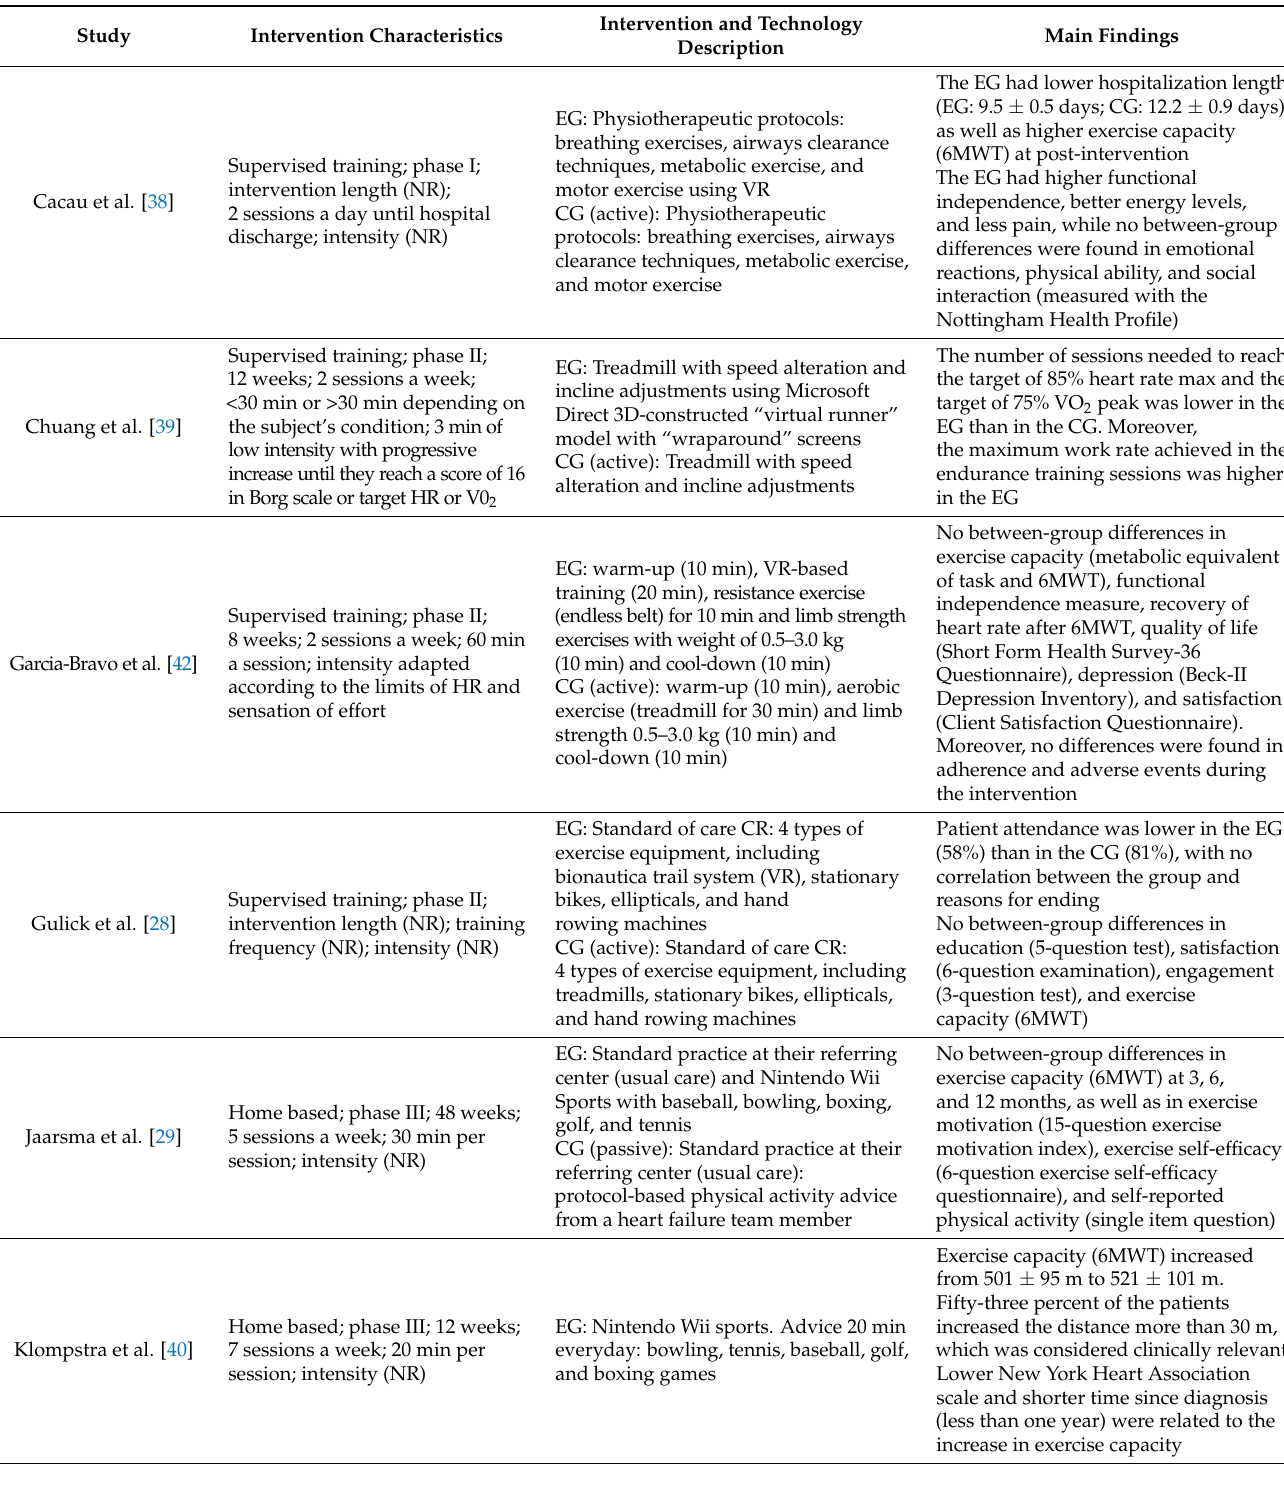
Table 2. Intervention characteristics and main